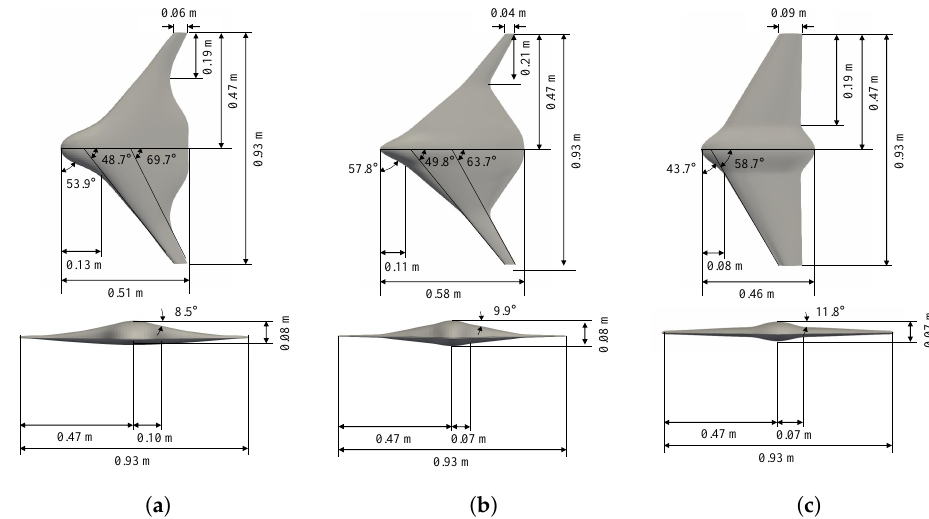
Figure 4. The configurations of the three baseline BWB aircraft. ( a ) Baseline model 1, ( b ) Baseline model 2, and ( c ) Baseline model